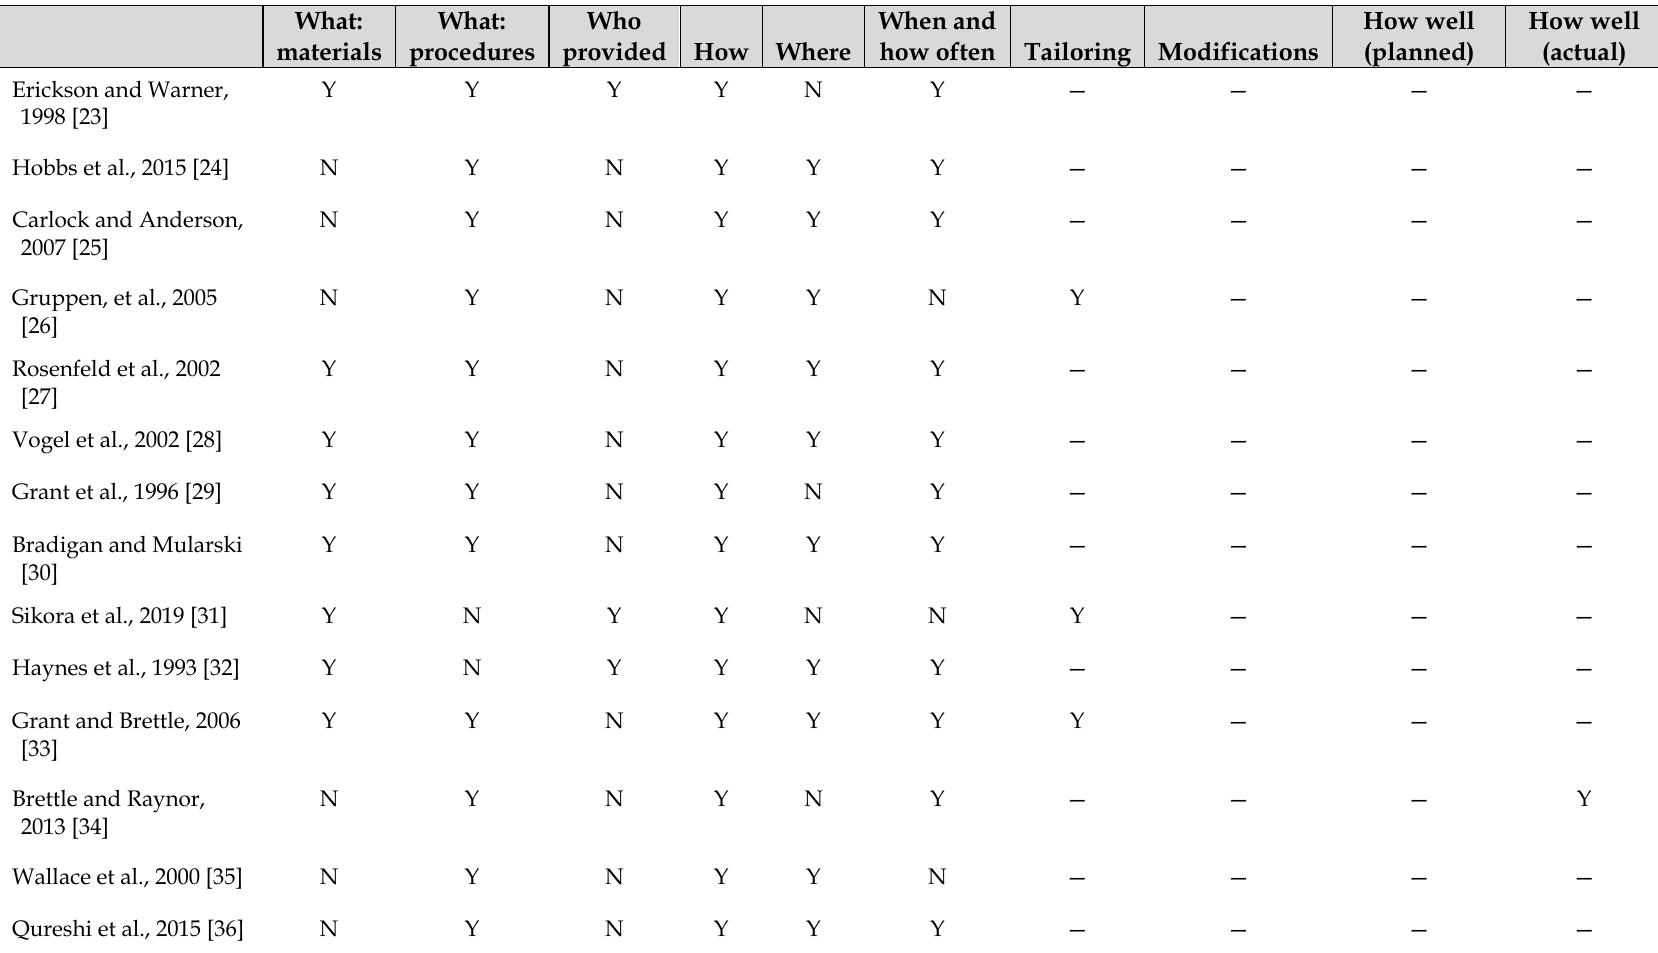
Table 3 Reporting assessment of included studies with Template for Intervention Description and Replication (TIDieR)